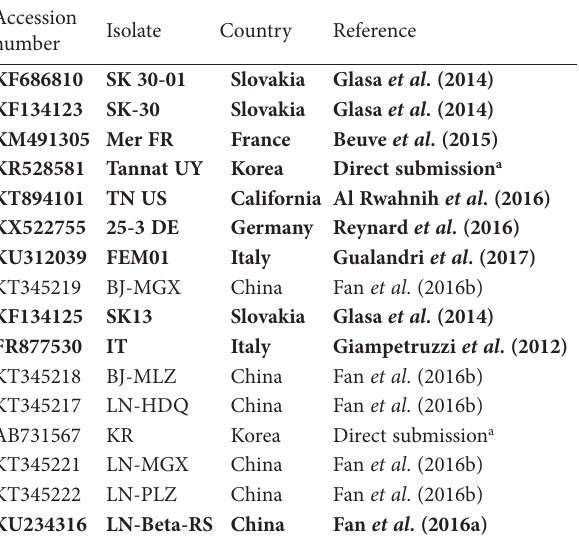
Table 1. Sequences used in this study to generate phylogenetic trees. All the sequences were used to construct the coat protein tree (see Figure 3 a), and the sequences in bold font were used for con- struction of the movement protein dendrogram (Figure 3